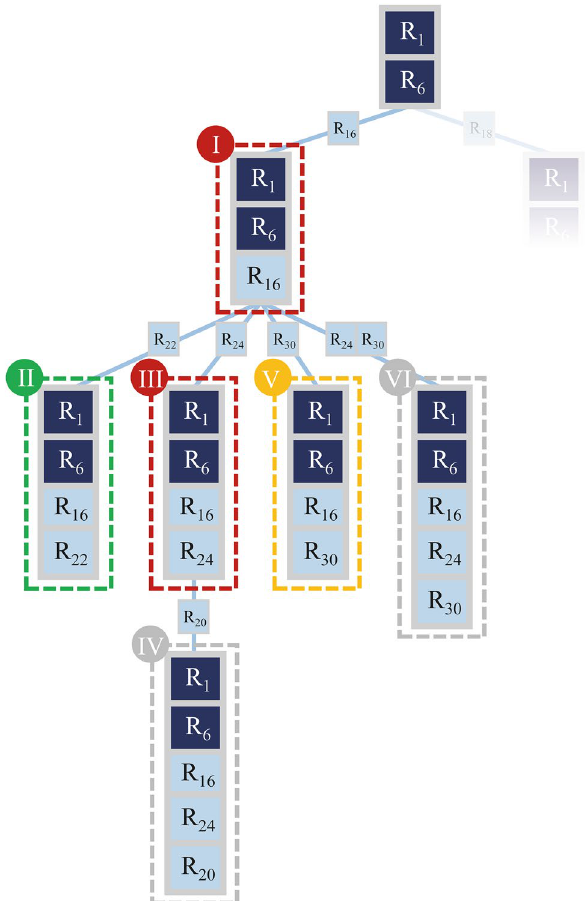
Figure 3. Schematic of a typical example of the depth-first search in our implementation. The squares represent targets. Here (R 1 , R 6 ) is a non-lethal set from the second step. The Roman numerals show the order of progress in examining the lethality of different sets. Light blue squares represent the targets that gain non-zero fluxes after removing some reactions. Node I and node III are non-lethal sets and their removal activates new potential targets ( ). Node II shows a lethal set and thus branching from this node is stopped ( ). Branching in node V is stopped because no new potential target could be activated ( ). Branching in nodes IV and VI are stopped because the maximum desired cardinality is reached ( ). After examining the sets corresponding to the R 16 branch, the process will continue for the R 18